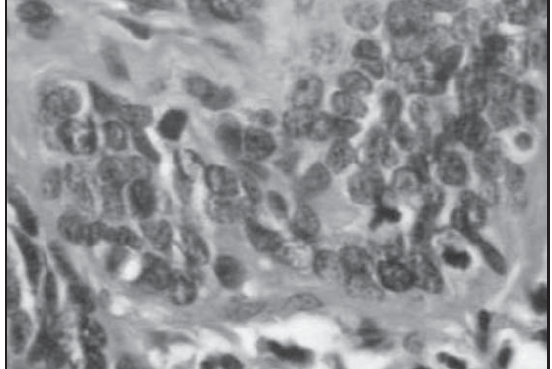
Figura 6 – Detalhe da imagem anterior mostrando bloco de células neoplásicas basalóides, pouco diferenciadas, com distribuição em paliçada na periferia (HE, 400x)